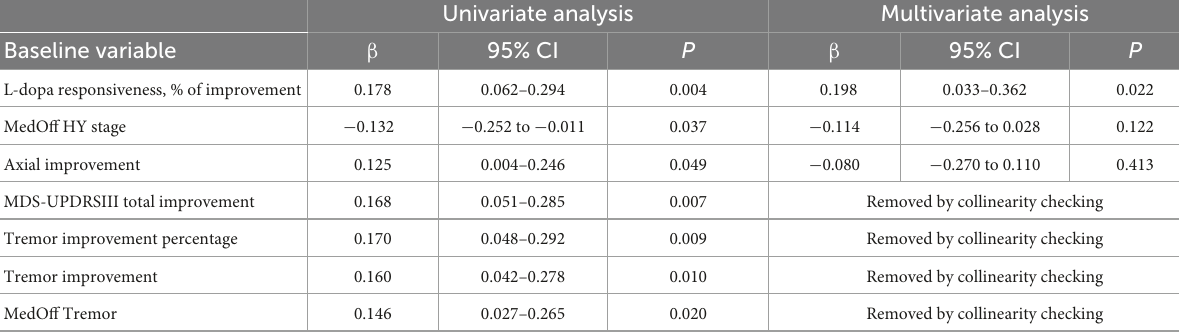
TABLE 6 Logistic regression analysis identified factors influencing short-term Motor outcome in the entire